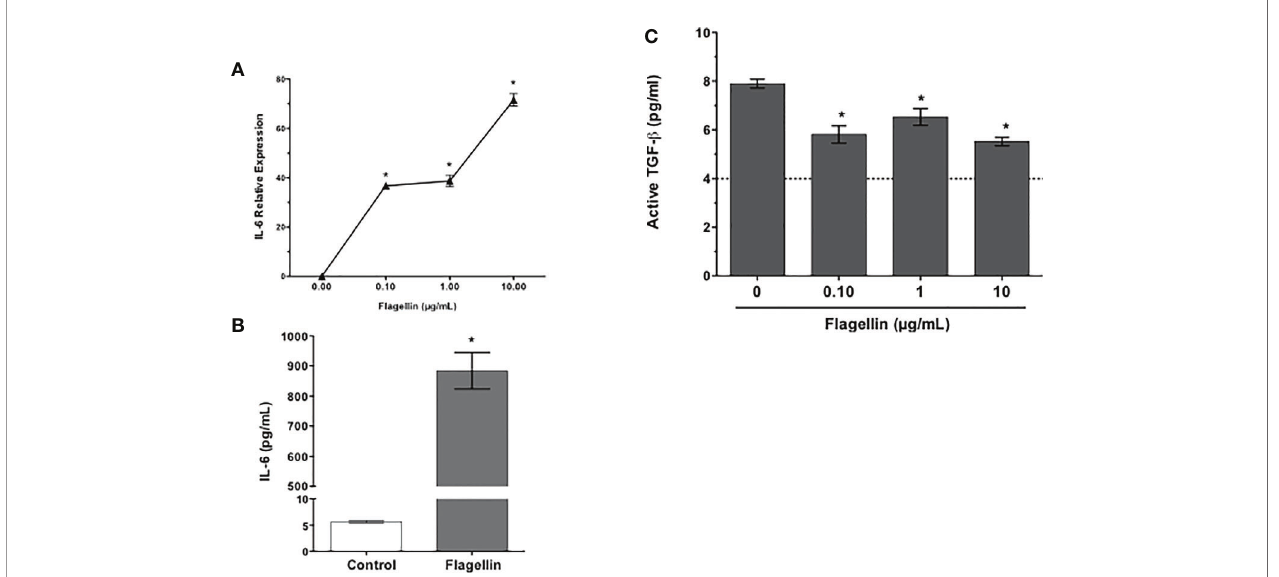
FIGURE 3 | Flagellin, a TLR5 ligand, reduces GC secretion of active TGF b . Cultures of GCs were stimulated with indicated concentrations of fl agellin for 24 h. The expression of IL-6 message (A) was detected by real-time PCR and IL-6 protein levels were determined by ELISA (B) in culture supernatants of GCs stimulated with 1 µg/ml fl agellin. Culture supernatants were also evaluated for their content of active TGF b (C) in a bioassay. The dotted line represents assay limit of detection. Data are expressed as mean ± SEM, n = 4, * p < 0.05.